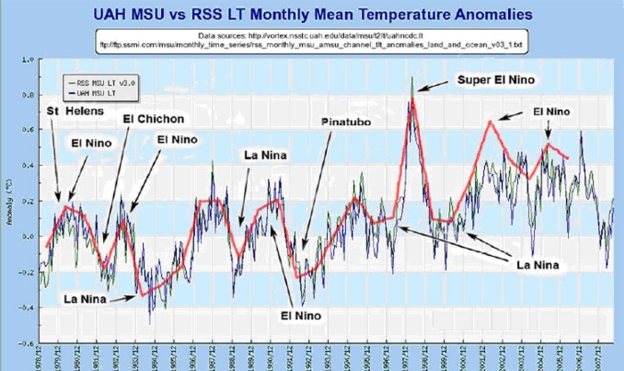
Climate events in relation to satellite global temperatures. Source: Arrak [50].